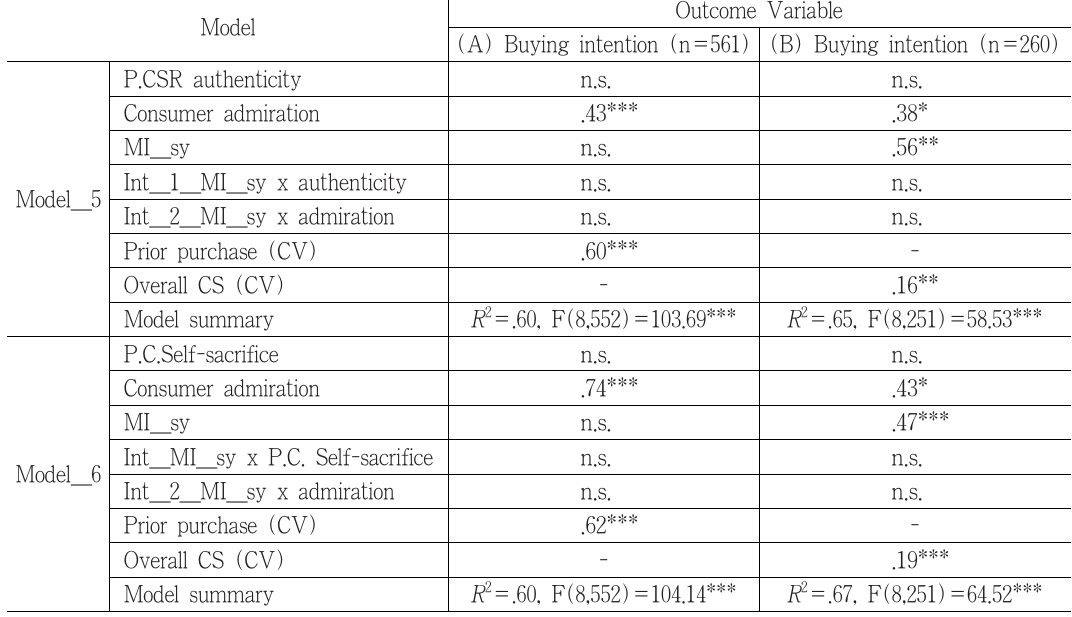
<Table 4b> The Results of Moderation Analysis of